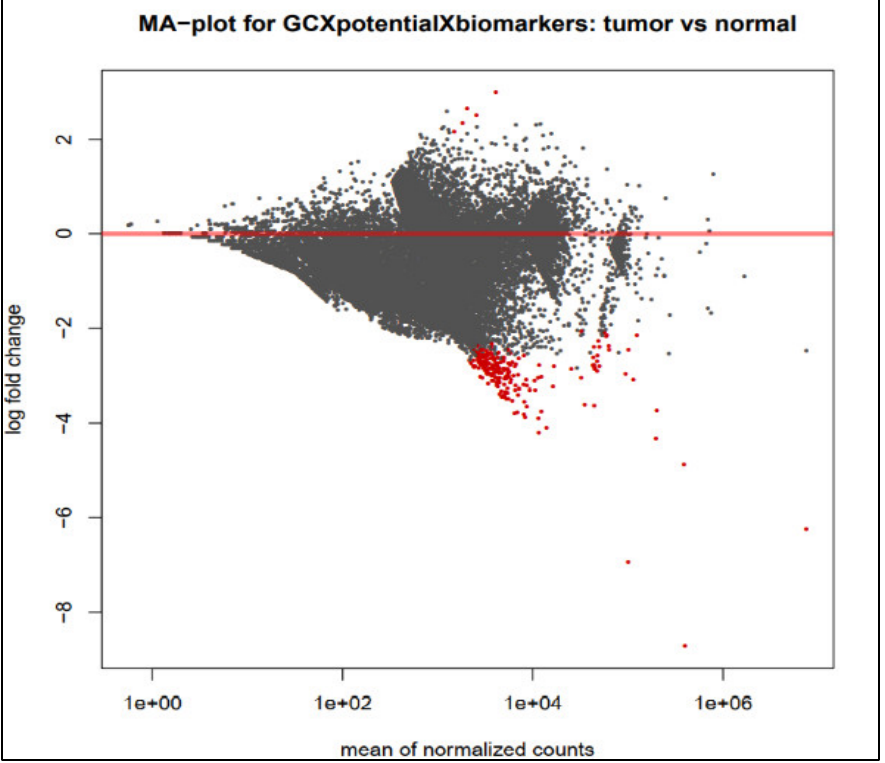
Figure 2. MA plot of differential expression analysis showing the log 2 FC over the mean of normalized read counts. The red dots display highly significant DEGs.